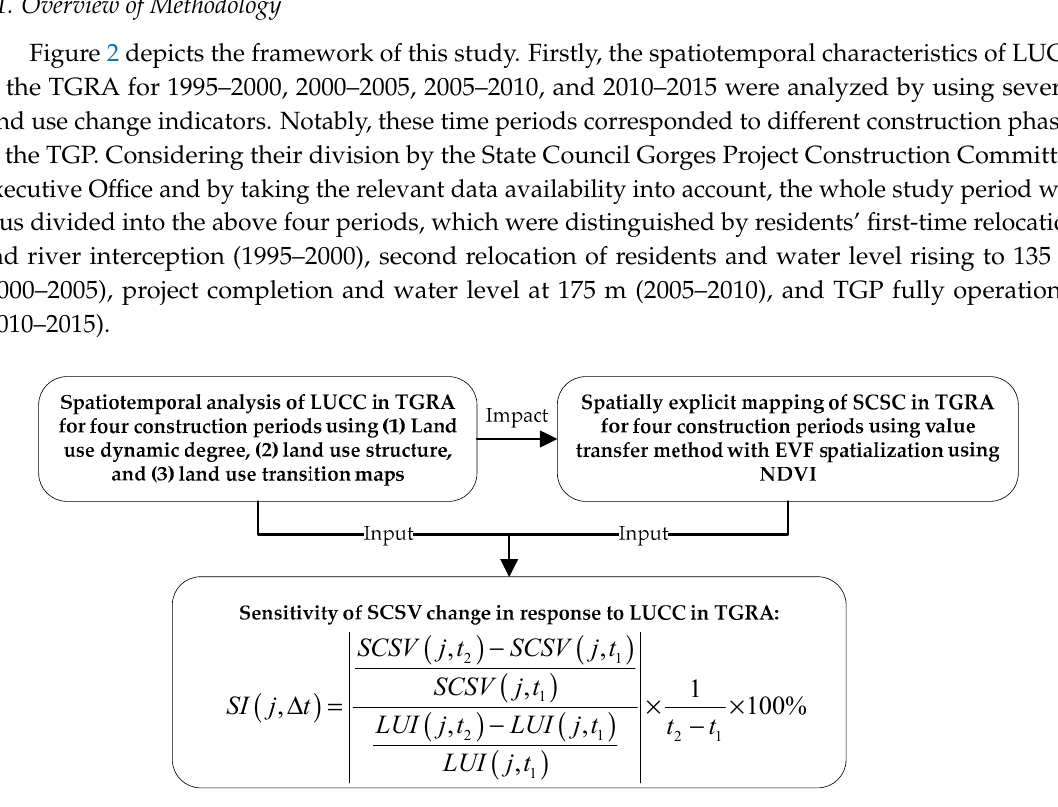
Figure 2. This study’s framework. EVF: equivalent value factor; NDVI: Normalized Difference Vegetation Index; LUCC: land use/cover change; TGRA: Three Gorges Reservoir Area; SCSV: Soil Conservation Service Value; LUI: land use intensity.